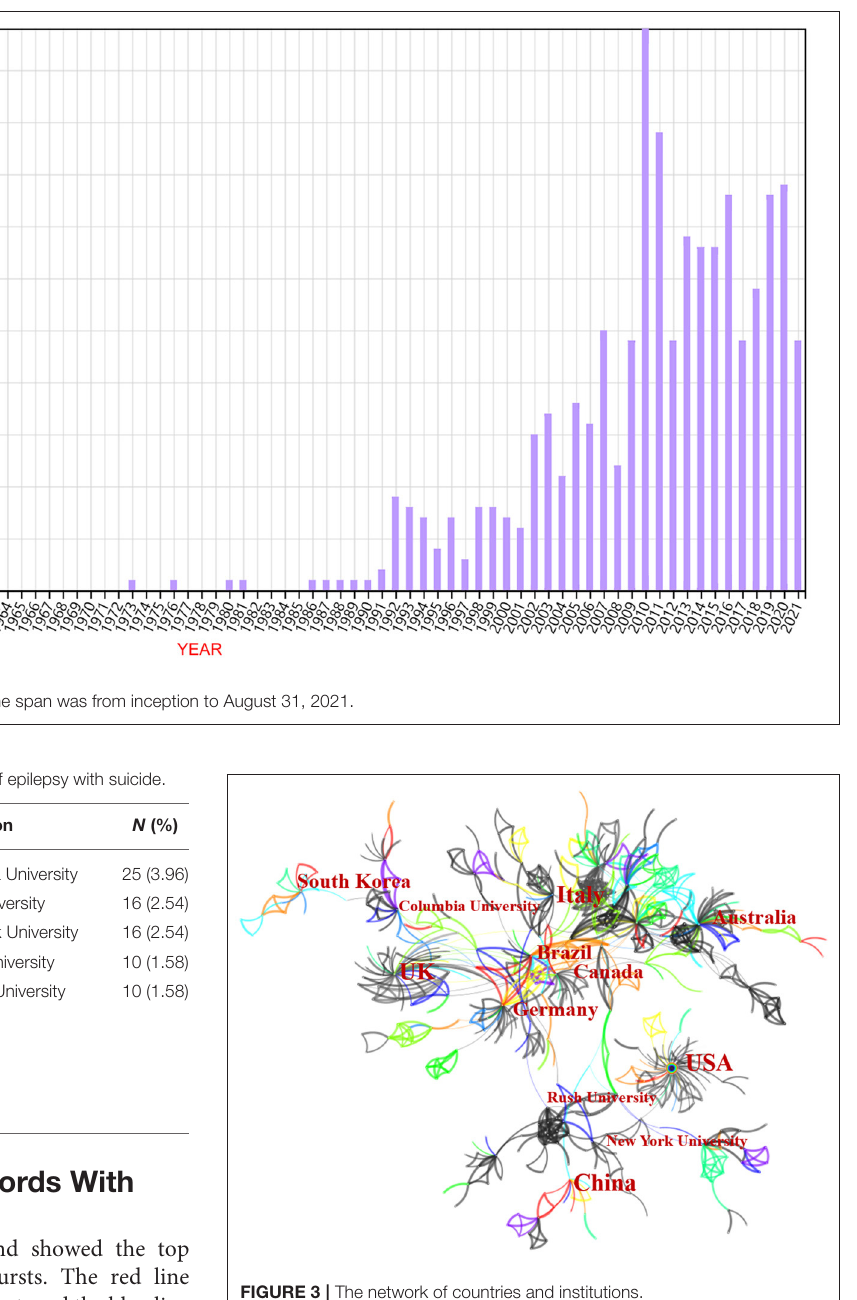
FIGURE 3 | The network of countries and